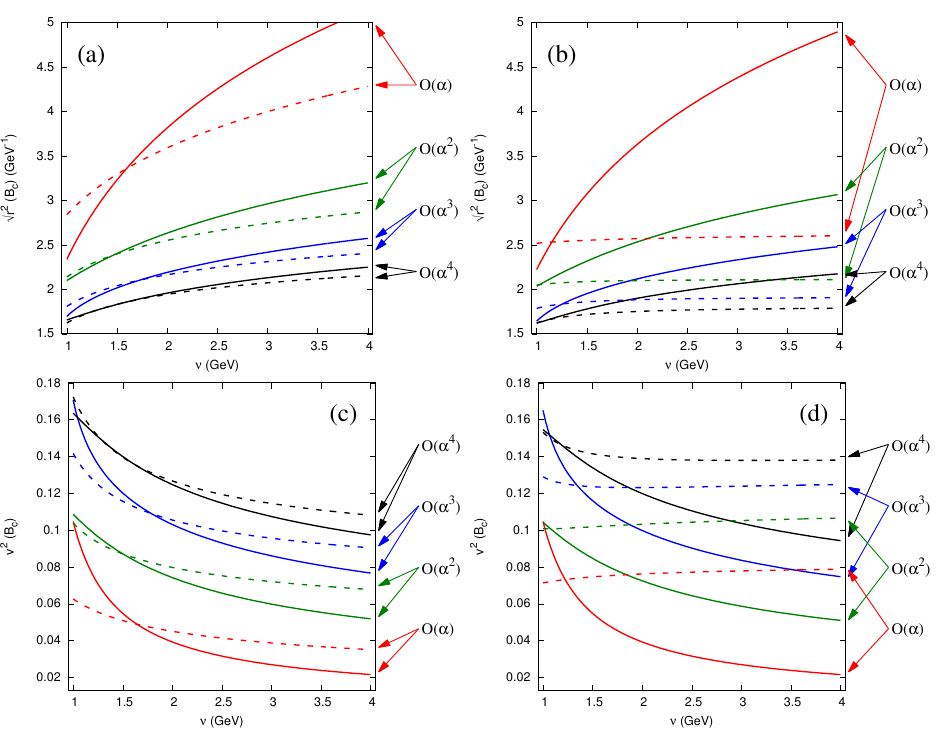
Figure 9 . Plot of the radius and v 2 of the B c in the RS’ scheme with (cid:23) f = 1 GeV and (cid:23) r = 1 (left panels), and with (cid:23) f = (cid:23) r = 0 : 7 GeV (right panels). They are obtained from solving eq. (4.1) for N = 0, 1, 2, 3. Continuous lines are evaluated with (cid:23) r = 1 and dashed lines with (cid:23) r = 1